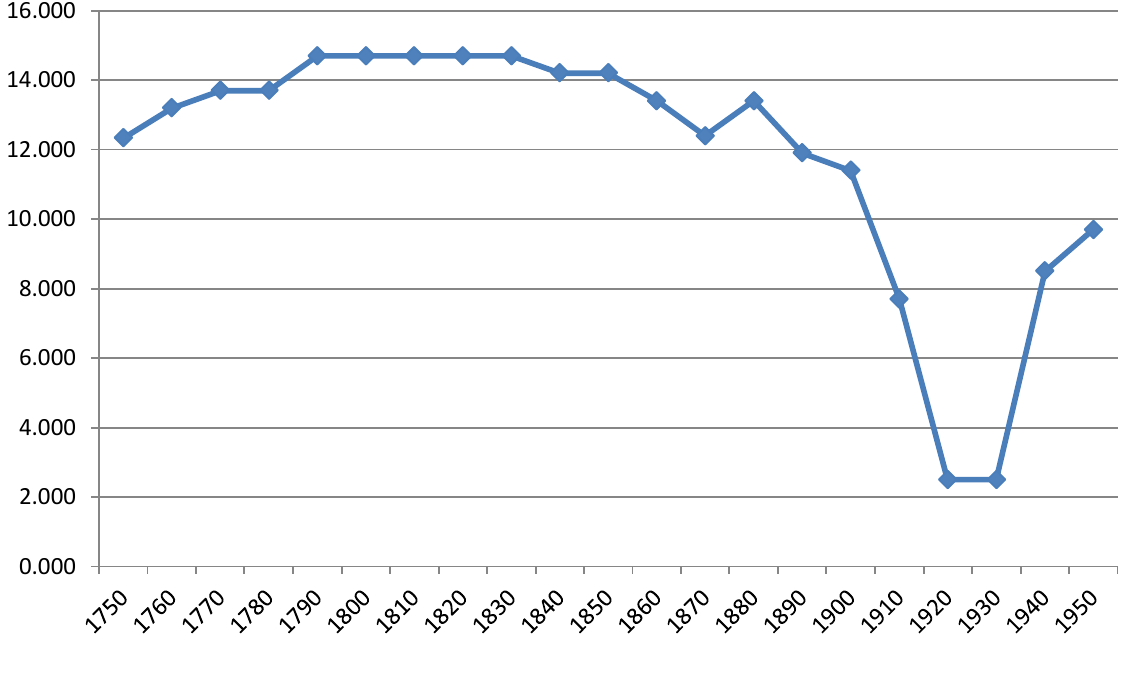
Source: Taagepera (1997: